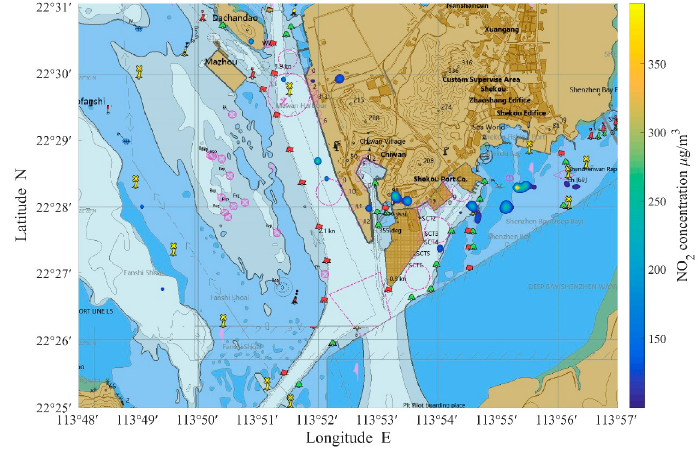
Figure 14. NO 2 concentration distribution at 3:00 (greater than 100 μ g/m 3 ).